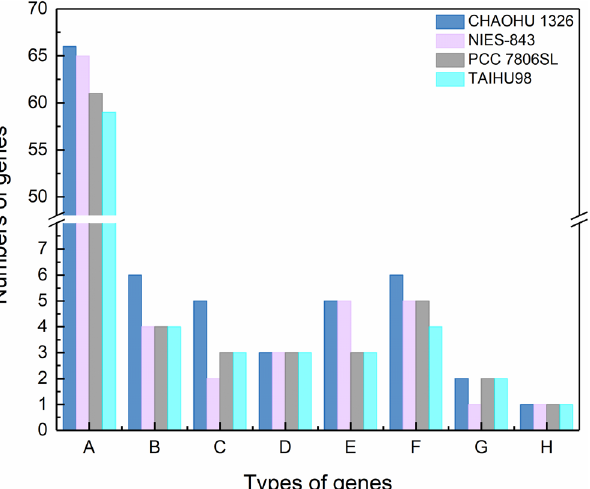
Figure 6. Types and numbers of genes encoding enzymes and proteins involved in extracellular polysaccharide biosynthesis and export in M. aeruginosa strains CHAOHU 1326, NIES-843, PCC 7806SL and TAIHU98. A: glycosyltransferases; B: isomerases; C: epimerases; D: phosphoglucomutases; E: glucose dehydrogenases; F: polysaccharide biosynthesis proteins; G: polysaccharide export proteins; H: bifunctional protein